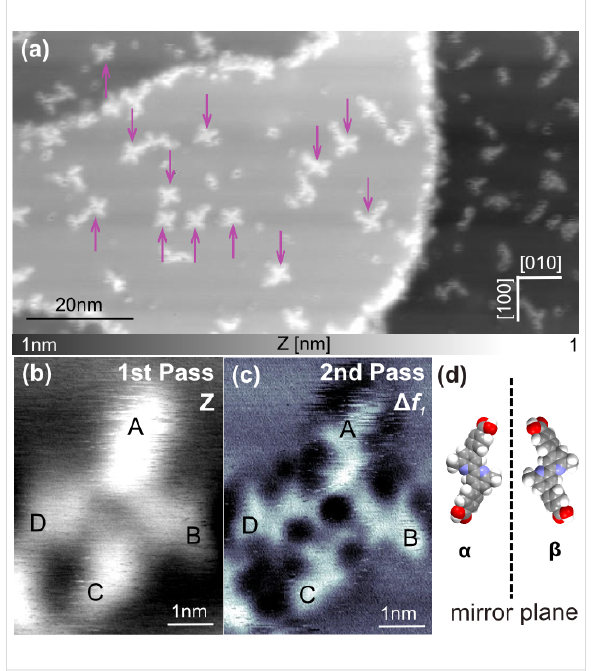
Figure 4: Windmill-shaped cluster on NiO(001). (a) Topographic image of DCPDMbpy forming molecular clusters on NiO(001). Violet arrows show that DCPDMbpy often form windmill-shaped clusters. (b) Topographic image of a molecular cluster formed by four DCPDMbpy molecules acquired in the first scanning pass (scan pa-